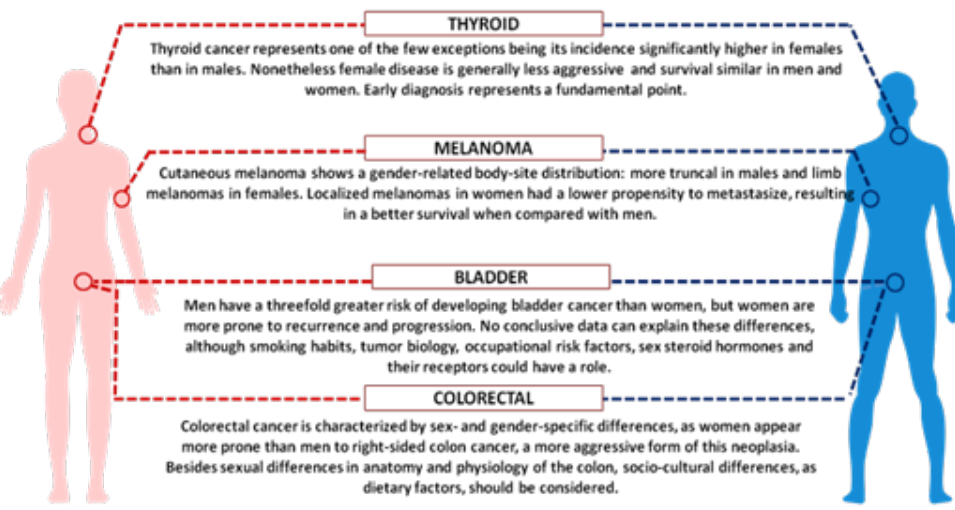
Figure 3. Schematic picture showing key examples of sex and gender disparities in cancer.